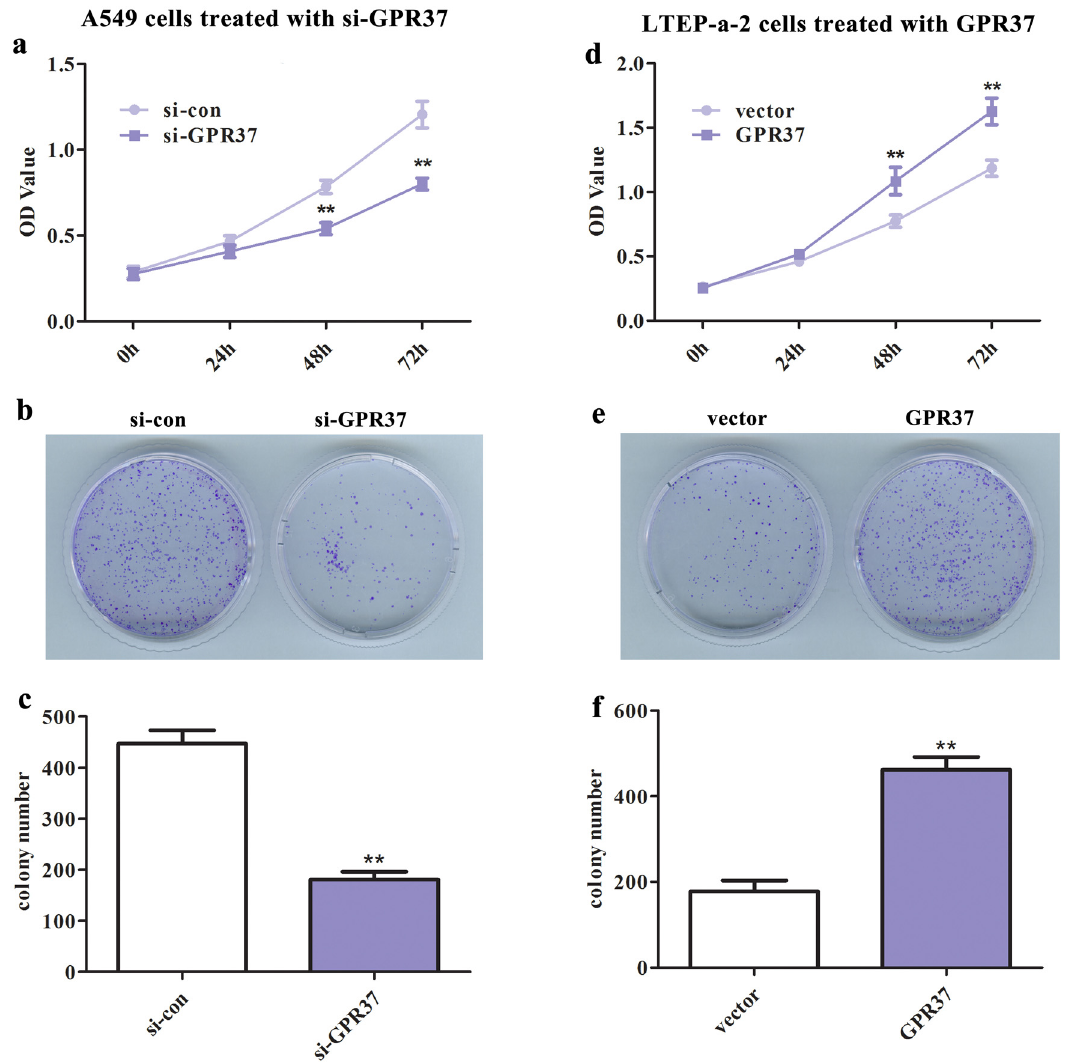
Figure 3: GPR37 contributed to promoting the proliferation of LUAD cells. CCK - 8 assay was carried out to measure the viability of ( a ) A549 cells treated with si - GPR37 ( ** P < 0.01 vs si - con group ) and ( d ) LTEP - a - 2 cells treated with pcDNA3.1 - GPR37 ( ** P < 0.01 vs vector group ) . Colony formation assay was conducted to assess the proliferative capacity of ( b and c ) A549 cells treated with si - GPR37 ( ** P < 0.01 vs si - con group ) and ( e and f ) LTEP - a - 2 cells treated with pcDNA3.1 - GPR37 ( ** P < 0.01 vs vector group )